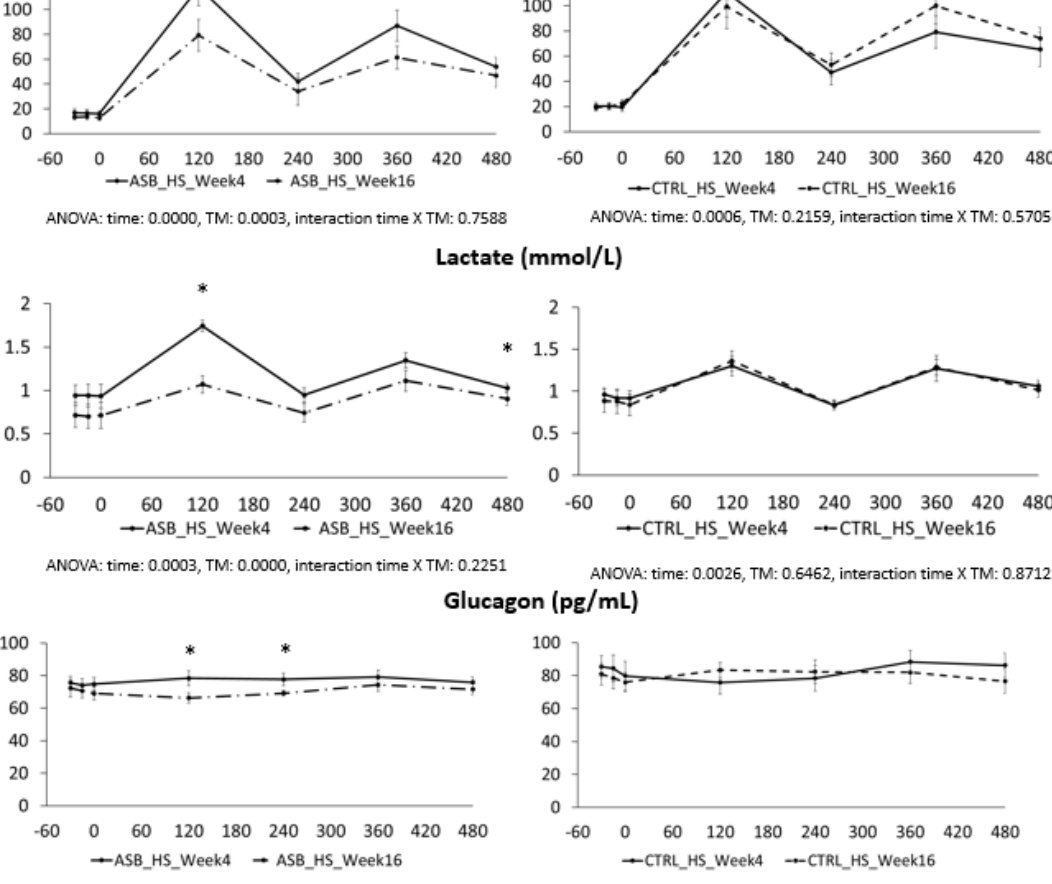
Figure 5. Plasma concentrations of glucose, insulin, lactate and glucagon in participants with hepatic steatosis. Data are expressed as mean ± SEM.; solid lines correspond to week 4, dotted lines to week 16. Results for ASB arm are shown on the left part, and for CTRL arm on the right part of the graph. Statistics (two-way ANOVA for repeated measurements with interaction) are reported at the bottom of each graph.